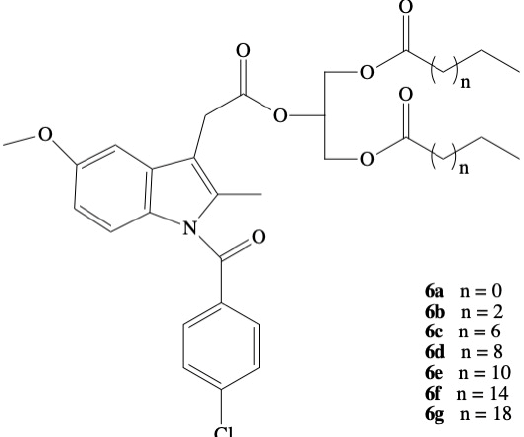
Figure 4. Chemical structure of 1,3-dialkanoyl-2-[1( p -chlorobenzoyl)-5-methoxy-2-methylindole-3- acetyl]glycerides 6a – 6g .